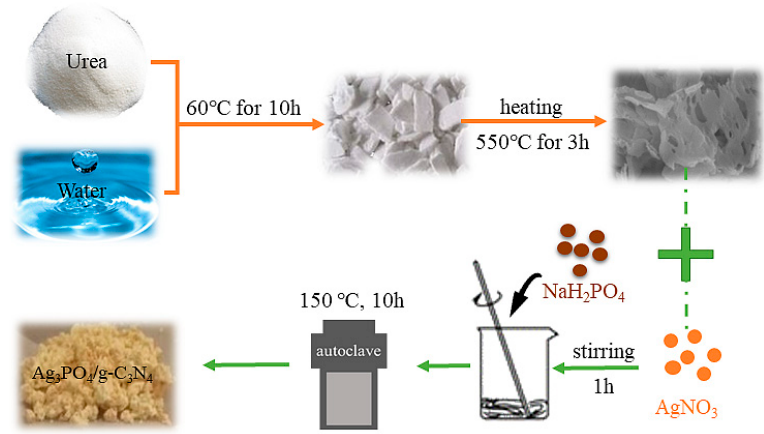
Figure 12. Schematic route for the synthesis of AgCN photocatalysts.